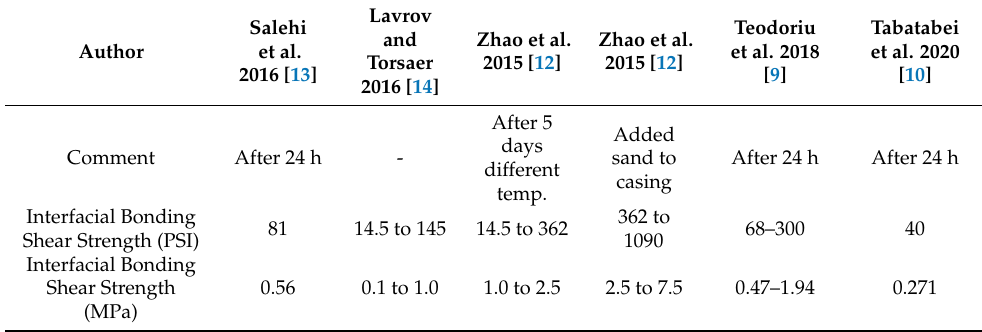
Table 1. Comparisonandvalidationofthepreliminaryresultsofthisworkwithvaluesinpublishedliterature.